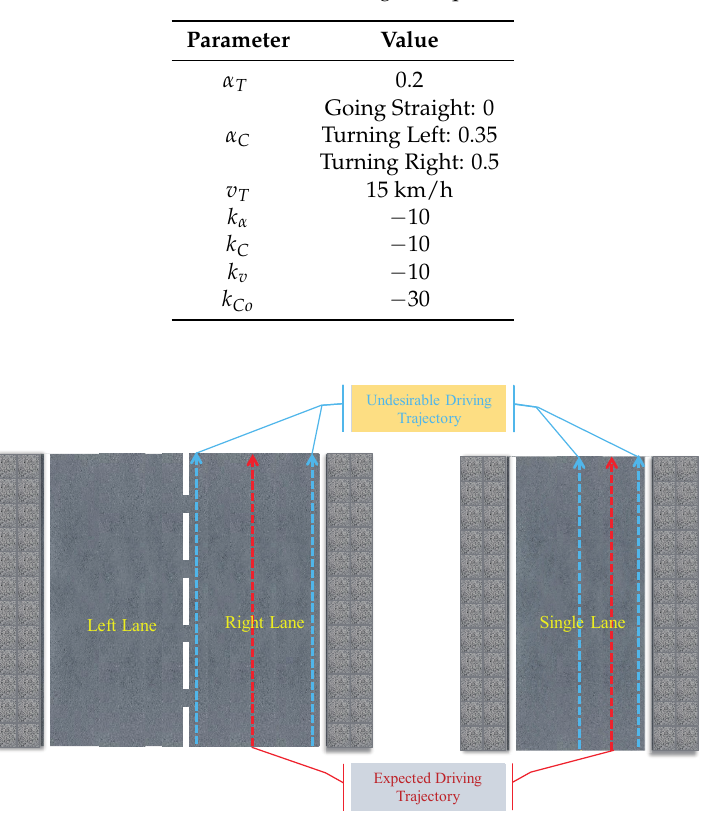
Figure 8. Schematic diagram of expected trajectories and undesirable driving trajectories. The red dotted arrow represents the trajectories we expect the vehicle to drive on this kind of road, and the blue dashed arrow represents the trajectories we do not expect the vehicle to drive on this road. At the same time, we will collect samples on these two types of trajectories for comparison